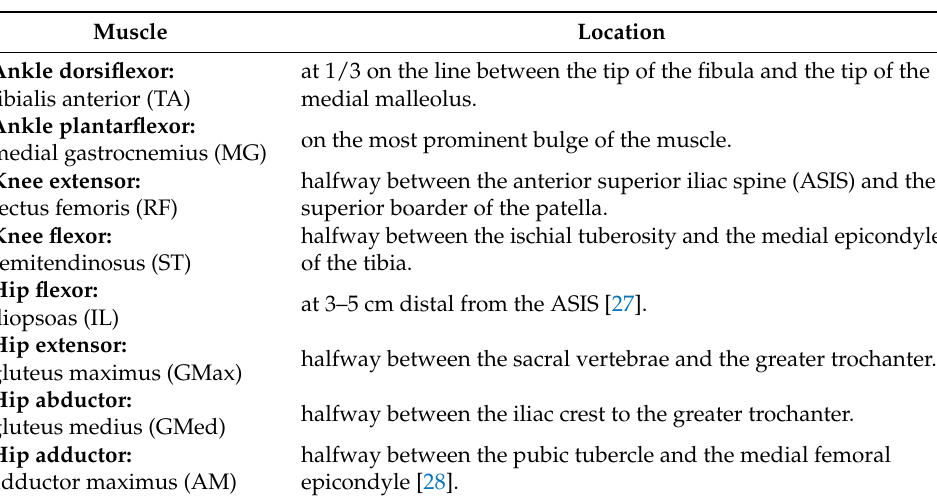
Table 1. Investigated muscles and locations of EMG sensor